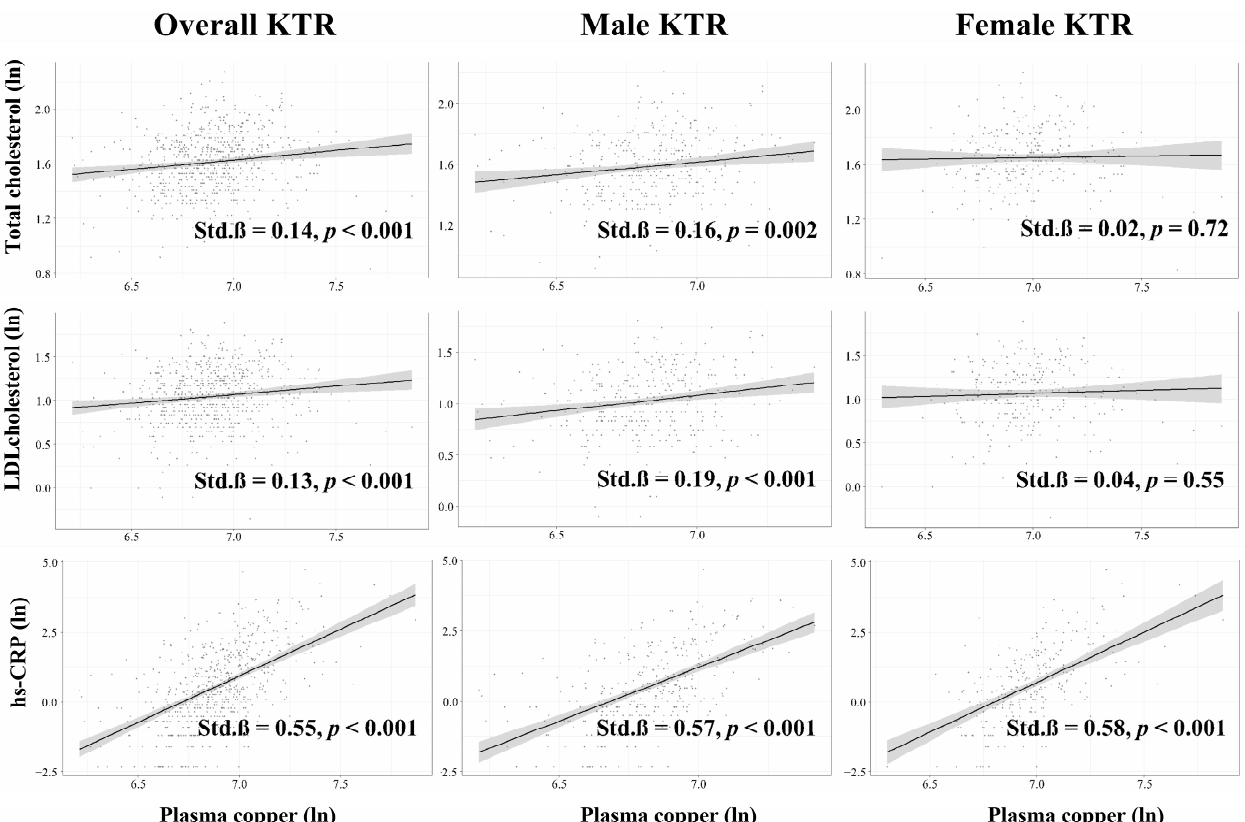
Figure 3. Association between plasma copper concentration and cardiovascular risk factors in KTR. Linear regression analyses among the overall KTR and among subgroups were performed. All var- iables were transformed to their natural logarithm. KTR, kidney transplant recipients; Std, stand- ardized; LDL, low-density lipoprotein; hs-CRP, high-sensitivity C-reactive protein; ln, natural log- arithm.